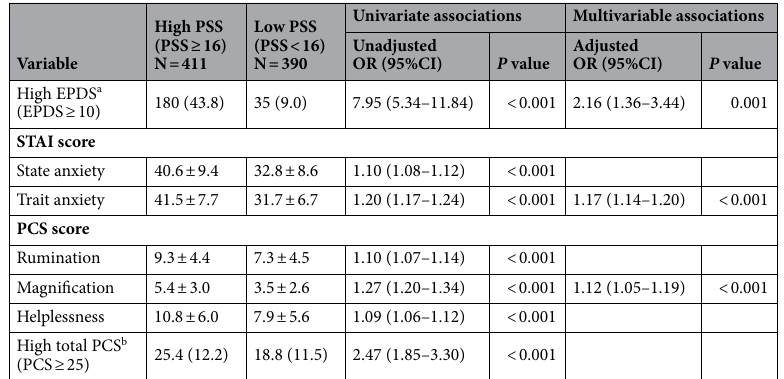
Table 2. Univariate and multivariable associations of depressive symptomatology, anxiety, and pain catastrophizing with perceived stress levels during labor. Data presented as n (%) or mean ± SD for categorical and continuous data respectively. a EPDS was analyzed as a categorical variable. b Total PCS was analyzed as a categorical